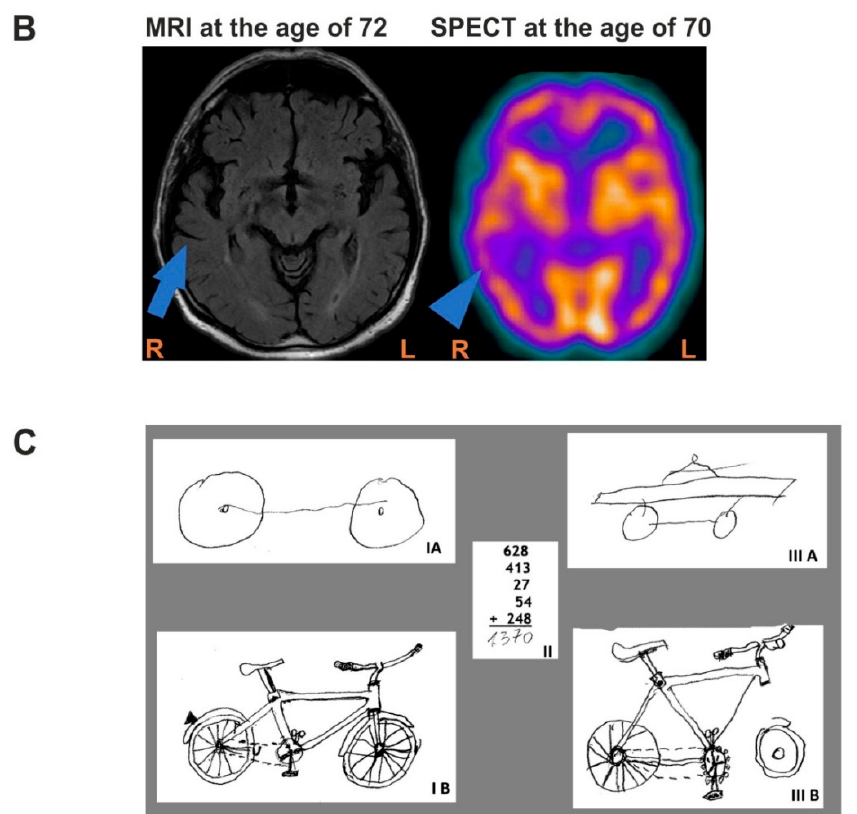
Figure 1. Family history, brain imaging of the patient, and drawing/calculation tasks. ( A ). Patient’s family history, shaded figures represent three family members who had some neuropsychiatric symptoms, but were not diagnosed with dementia; ( B ). Mild atrophy of right temporal lobe (arrow) on transaxial MRI image (left panel); Reduced perfusion in right temporal lobe (arrowhead) and slightly reduced perfusion, diffused in both frontal lobes in SPECT (right panel); Abbreviations: R- right, L-left; MRI, magnetic resonance imaging; ( C ). Drawing, copying, and calculation tasks demonstrating the dissociation between impaired semantics and well preserved visuospatial processing (inability to retrieve specific features of an object with good visuoperceptual and visuoconstructive functions) and calculation. I A. Drawing a bicycle to a verbal command at the age of 71. I B. Copy of a bicycle drawing at the age of 71. II. The calculation task was performed correctly at the age of 71, as well as at the age of 72. III A. Drawing a bicycle to a verbal command at the age of 72. III B. Copy of a bicycle drawing at the age of